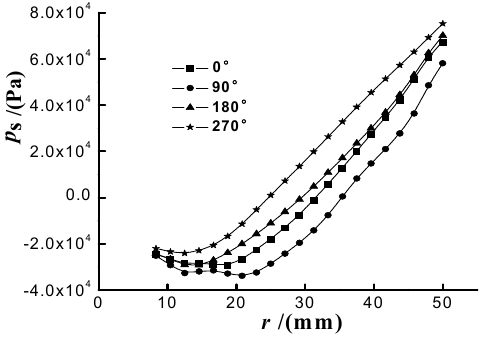
Figure 6. Static pressure distribution for the axial cross-section Z = − 10 mm along the radial direction.